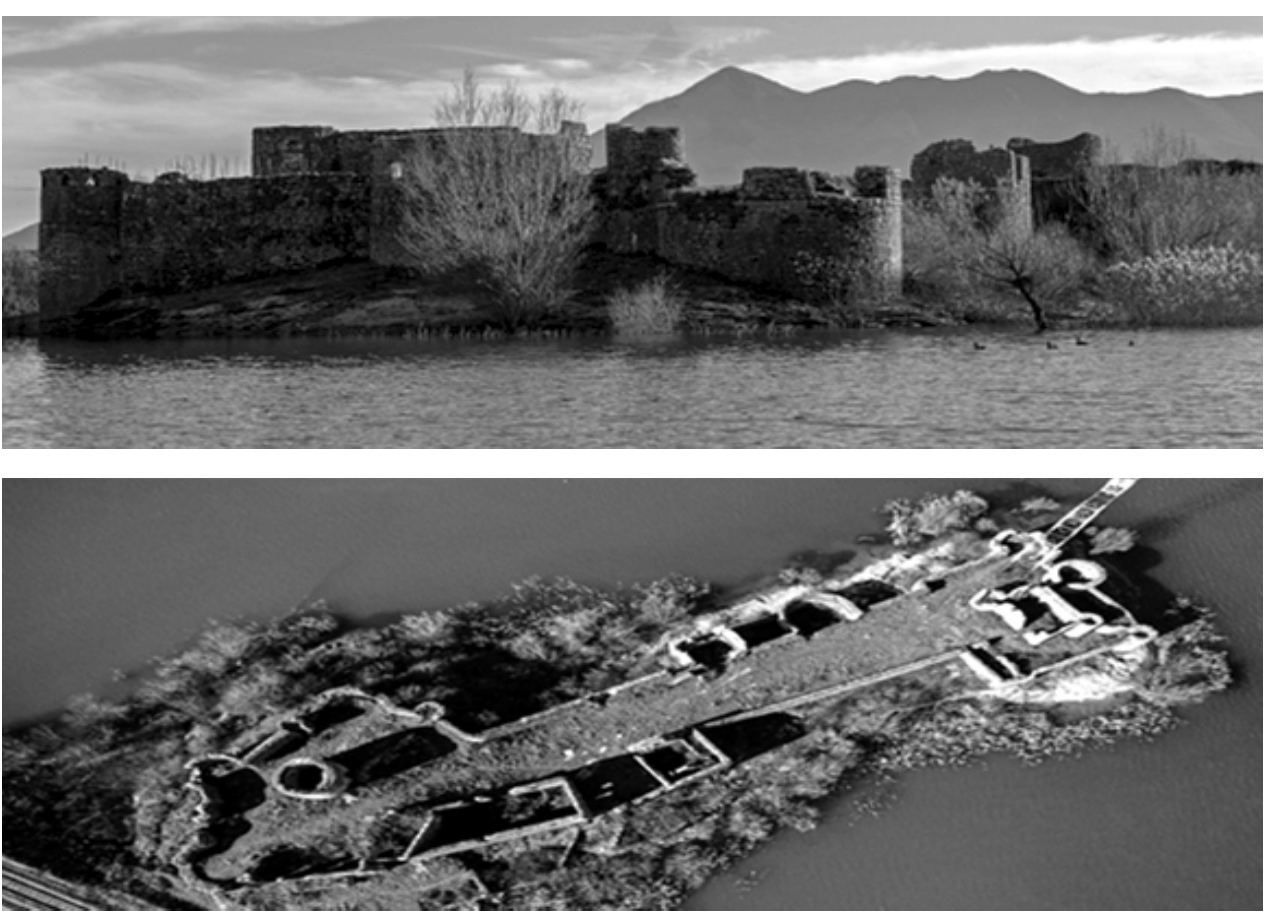
Figure 7. Lesendro (Photo: D. Starcevic) .